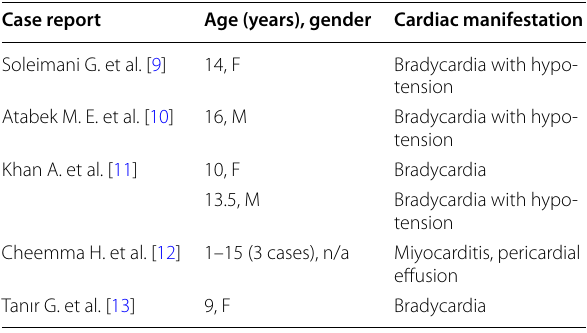
Table 2 Brief literature review of sporadic cases of acute